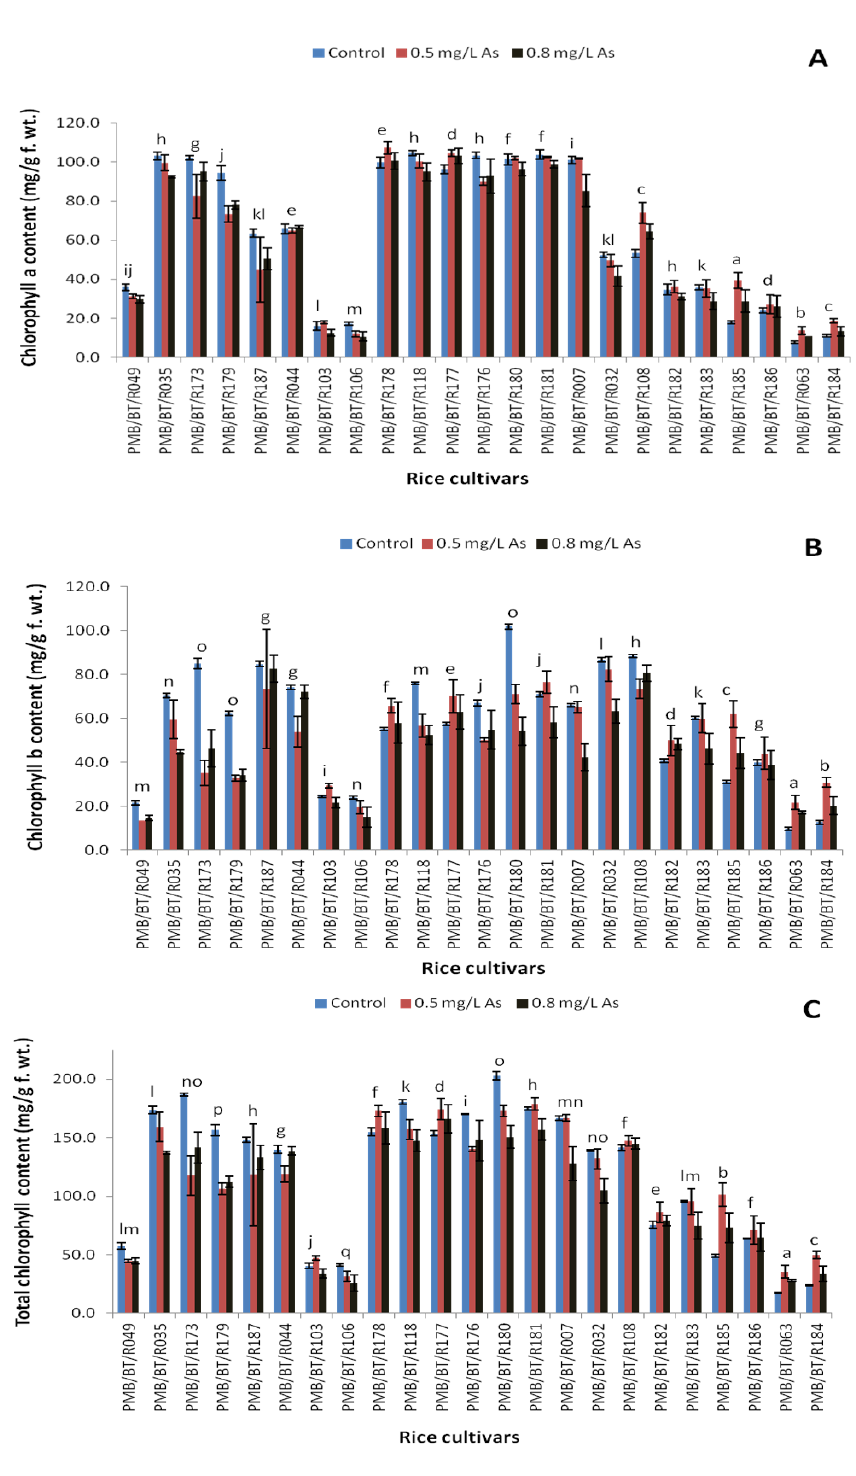
Figure 4 Chlorophyll contents (mg/g fresh weight) under arsenic stress. Chlorophyll a ( A ), chlorophyll b ( B ), and total chlorophyll ( C ). Data are presented as the mean ± SE , n = 3. Columns topped by the same letter(s) indicate that the percentage changes in the parameter values of the presented cultivars under 0.8 mg/L arsenic stress do not differ significantly at the 5% level according to Duncan’s multiple-range